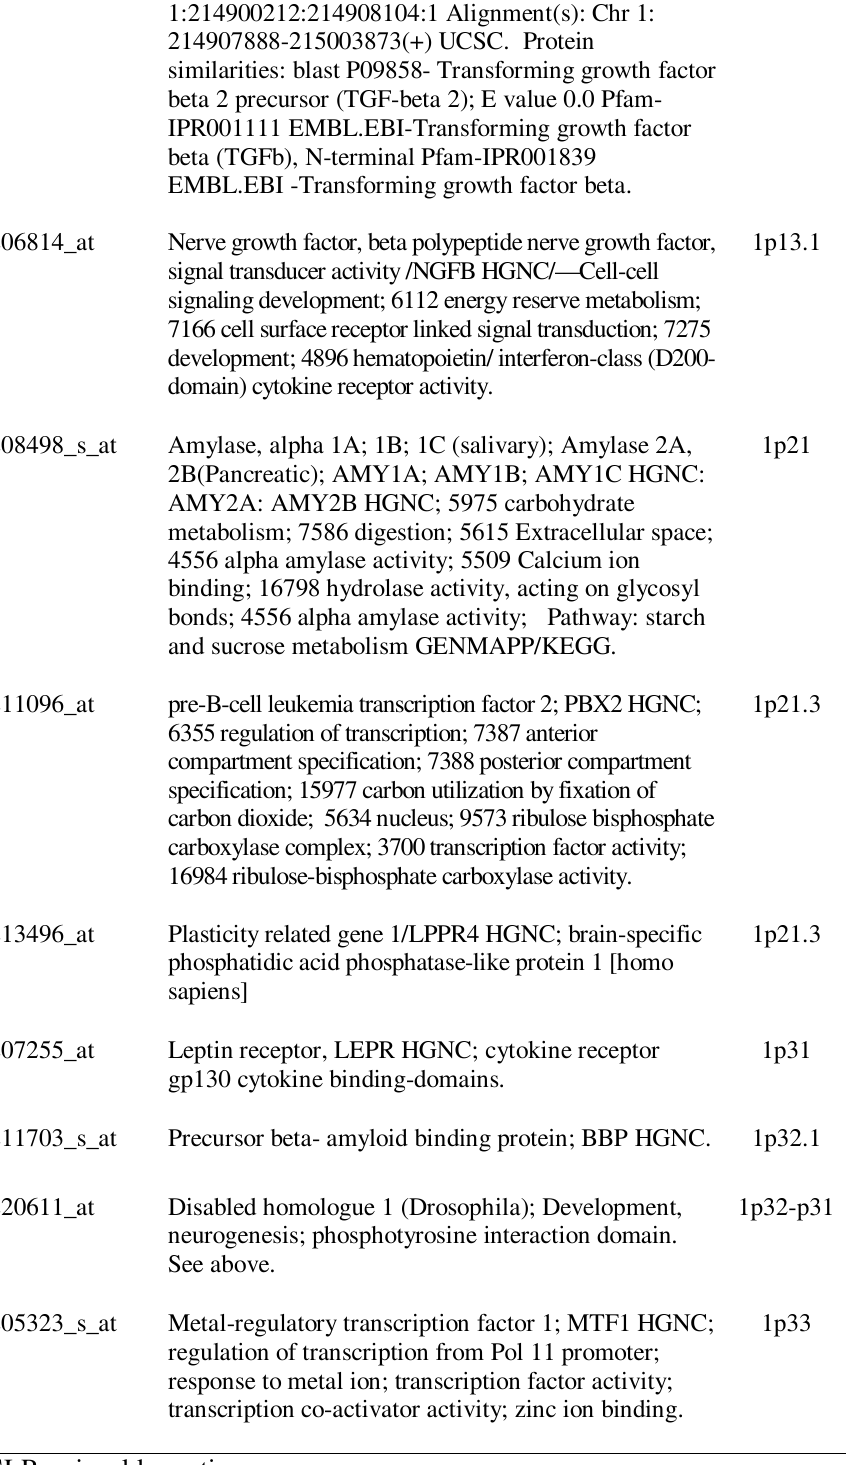
SLR-- signal log ratios